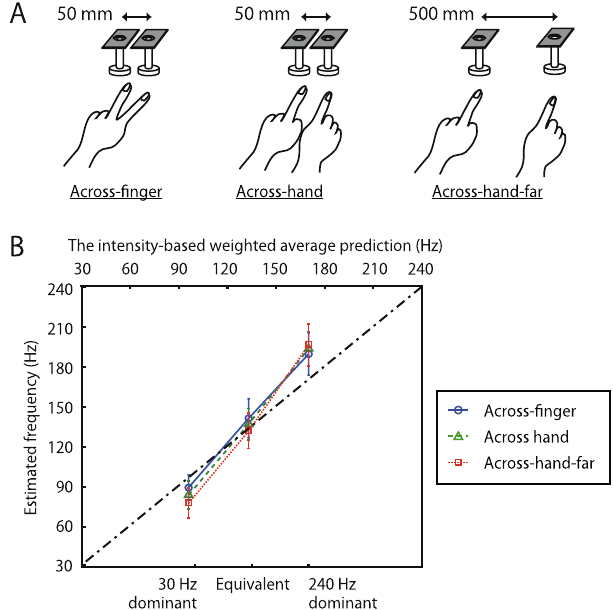
Figure 5. Effects of somatotopic and environmental separations in interpolation experiments. ( A ) Schematic views of the setup. ( B ) Experimental results. Blue circles with a solid line represent averaged PSEs of the target pair of the Across-finger condition, green triangles with dashed line represent that of the Across-hand condition, and red squares with a dotted line represent that of the Across-hand-far condition, all averaged across ten participants. The dot-dash-line represents intensity-based linear interpolation of 30 and 240 Hz. N = 10. Error bars indicate ± 1